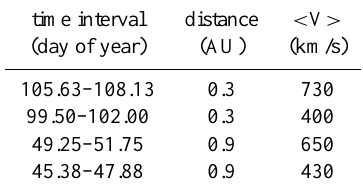
Table 1. HELIOS data: fast and slow